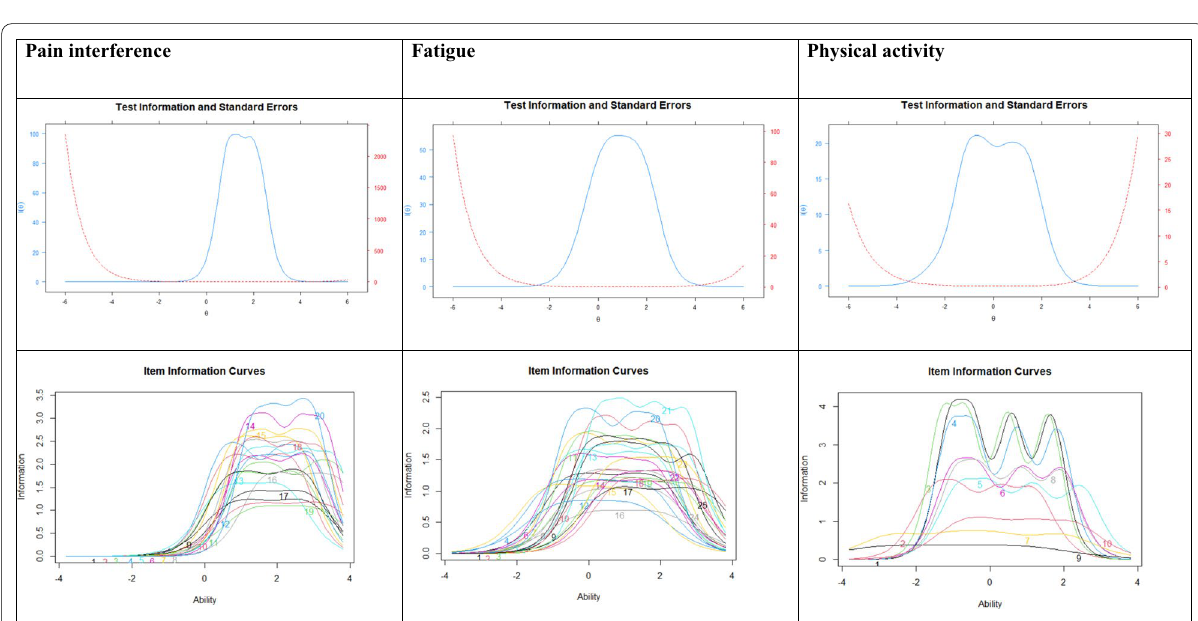
Fig. 3 Test information function, standard error, item information curves of the Swedish translated PROMIS item